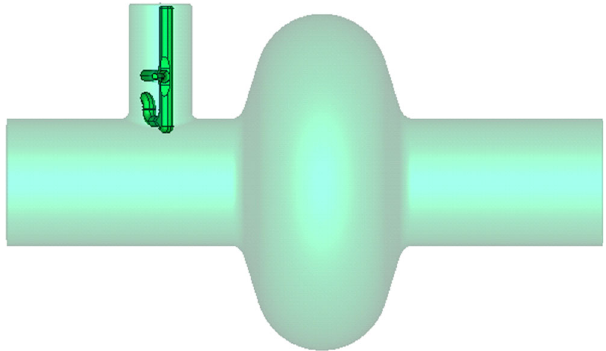
FIG. 3. One-cell cavity model for MP simulations in an ILC cavity.